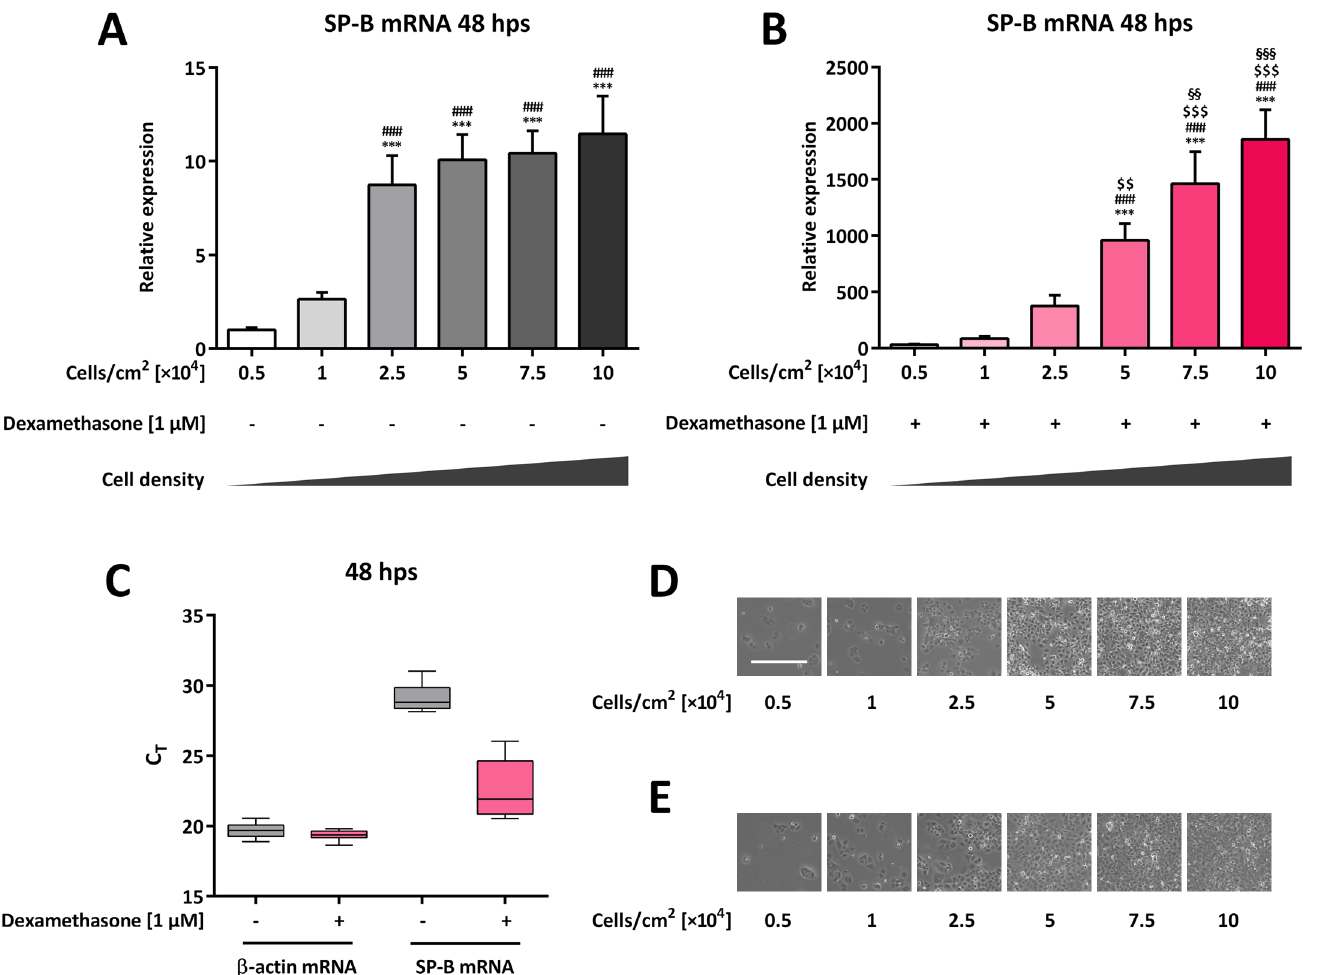
Fig 1. Impact of cell density on SP-B mRNA expressionin H441 cells. Different quantities of H441 cells were seeded as indicatedand either left untreated ( A , D ) or incubatedwith 1 μ M dexamethasone for 48 h ( B , E ). SP-B mRNA levels were normalizedto β -actinand fold differences comparedto 0.5 × 10 4 untreated cells per cm 2 were calculated( A , B ). Means +SD of n = 4 independentexperiments are shown. ( C ) C T range achievedfor β -actin and SP-B mRNA combinedfor all different cell quantitieswith and without dexamethasone treatment. ( D , E ) Representative bright field images of H441 cells at different quantitieswithout ( D ) and with ( E ) dexamethasone treatment. The bar in the upper left image represents 500 μ m. *** p < 0.001 comparedto 0.5 × 10 4 cells per cm 2 , ### p < 0.001 comparedto 1 × 10 4 cells per cm 2 , $ $ p < 0.0 1 and $ $ $ p < 0.001 comparedto 2.5 × 10 4 cells per cm 2 , §§ p < 0.01 and §§§ p < 0.001 comparedto 5 × 10 4 cells per cm 2 .